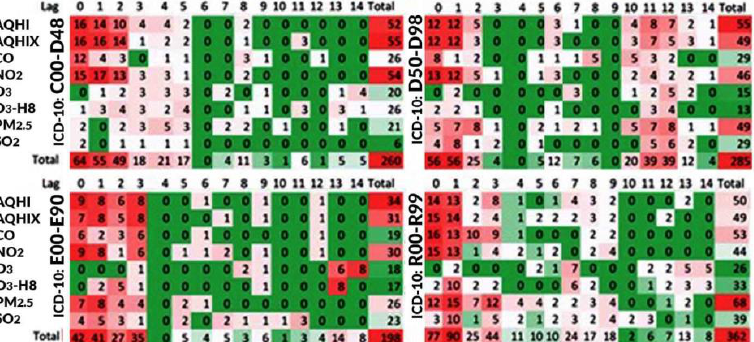
Figure 1. Frequencies of the numbers of positive statistically significant ( p -value < 0.05) associations